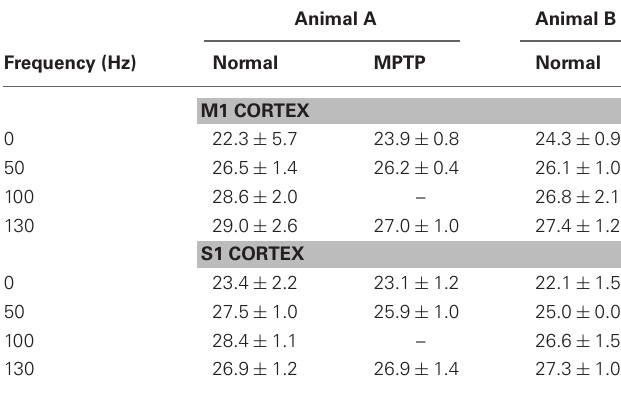
Table 3 | Information Rate ( IR , in bits/s) (mean ± std.dev.).